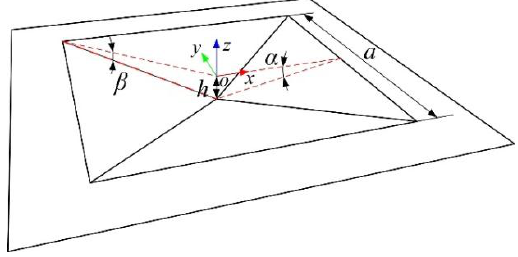
Figure 13. The relationship between stress difference ( σ = S y − S x ) and l 1 for two diaphragm structures.